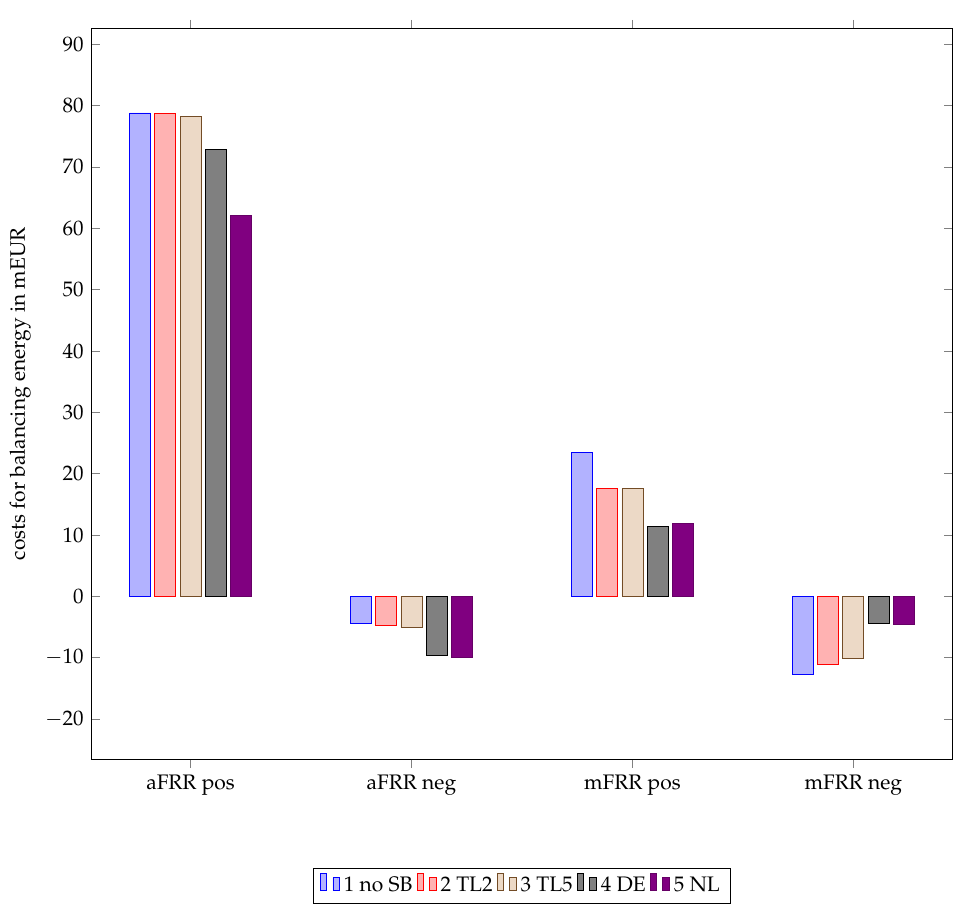
Figure 7. Smart Balancing simulation - Costs for balancing energy in 2019 Figure 7. Smart balancing simulation: costs for balancing energy in 2019.